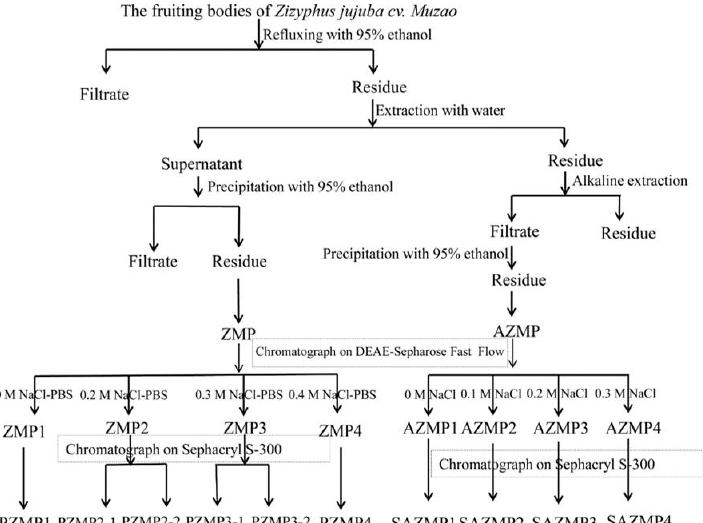
Figure 1 . The separation flow diagram of Ziziphus Jujuba cv. Muzao polysaccharides . Figure 1. The separation flow diagram of Ziziphus Jujuba cv. Muzao